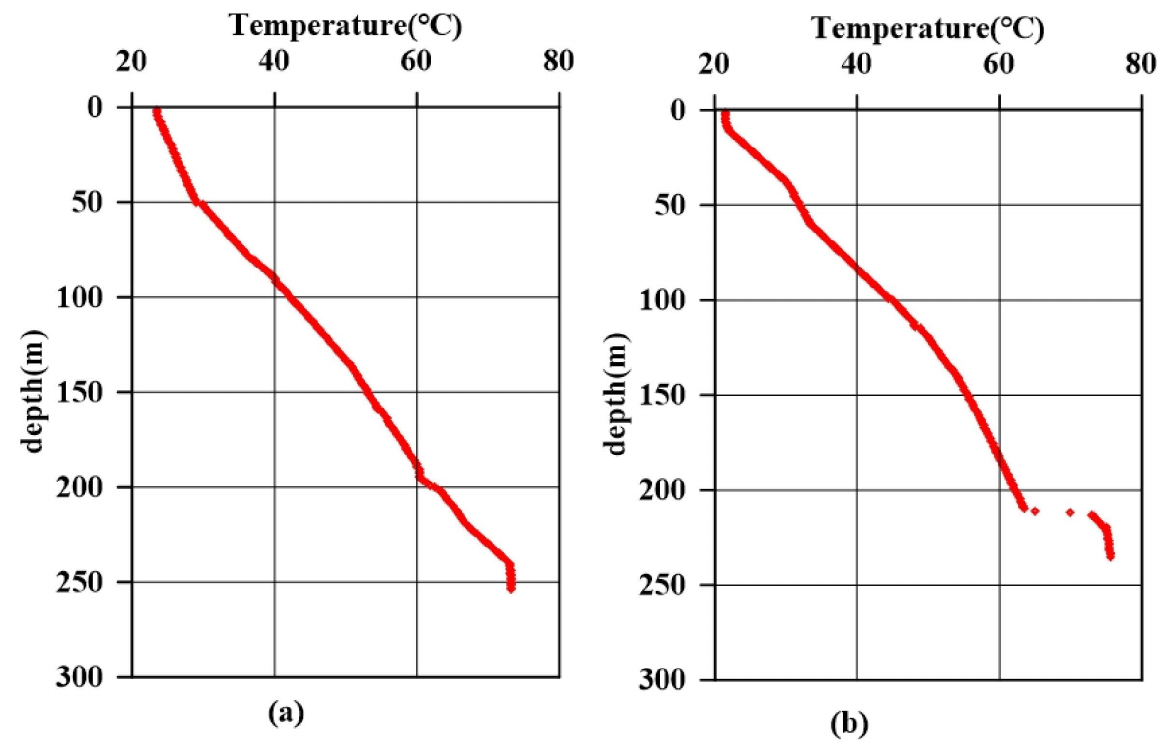
Figure 2. The graphs show two typical patterns (A type ( a ) and B type ( b )) for the temperature logging data of the geothermal water wells